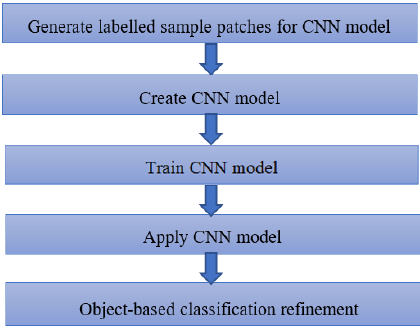
Figure 7. Flowchart showing a convolutional neural network (CNN) and classification refinement workflow in eCognition software.